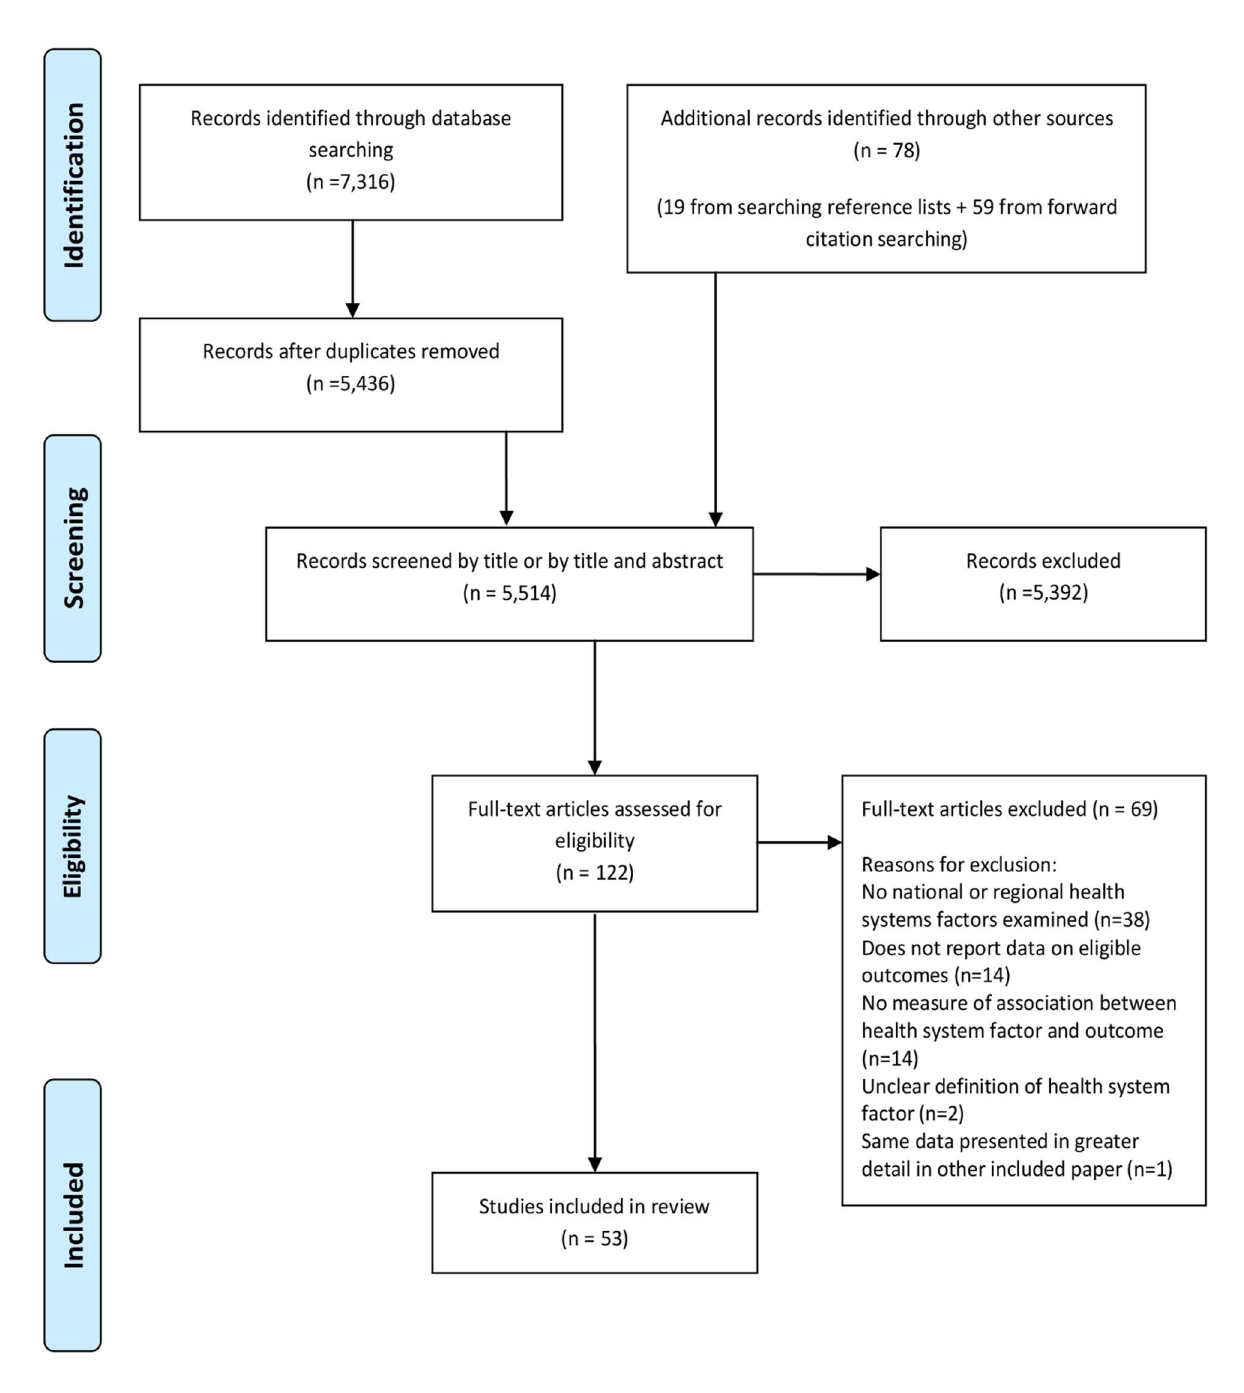
Figure 2. PRISMA flowchart.